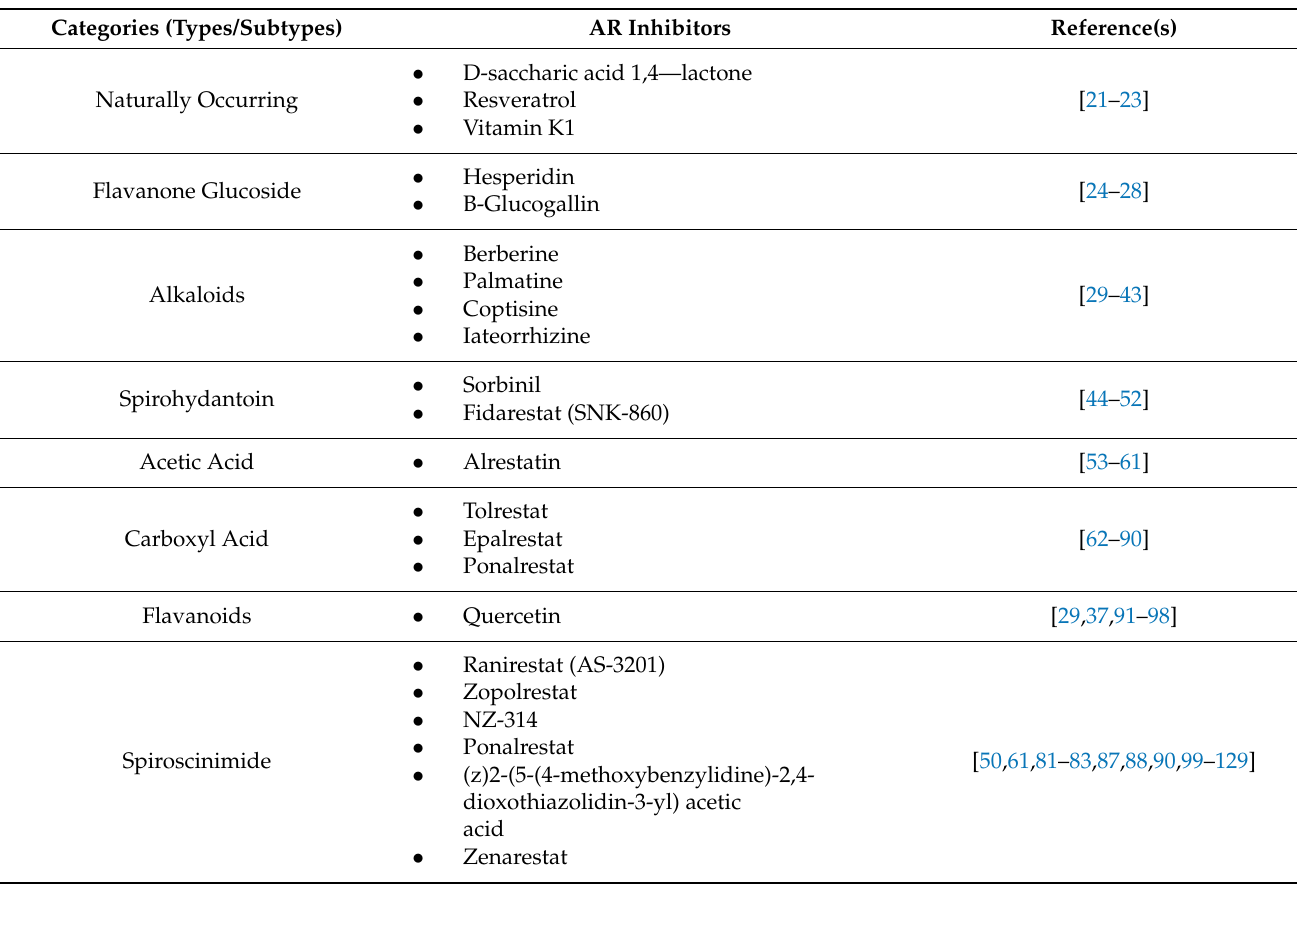
Table 2. A select list of aldose reductase (AR) inhibitors. Different categories (types, and subtypes) of AR inhibitors have been developed and tested both in experimental animals as well as in human subjects.